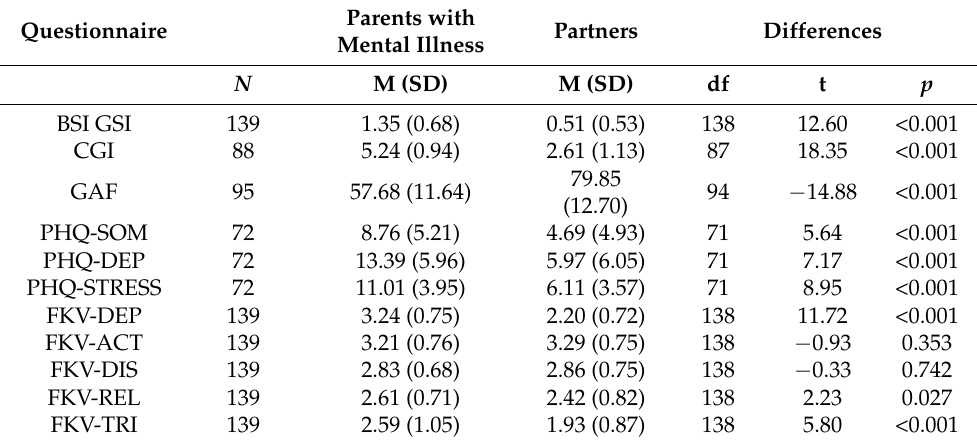
Table 2. Clinical statistics of the sample. Questionnaire